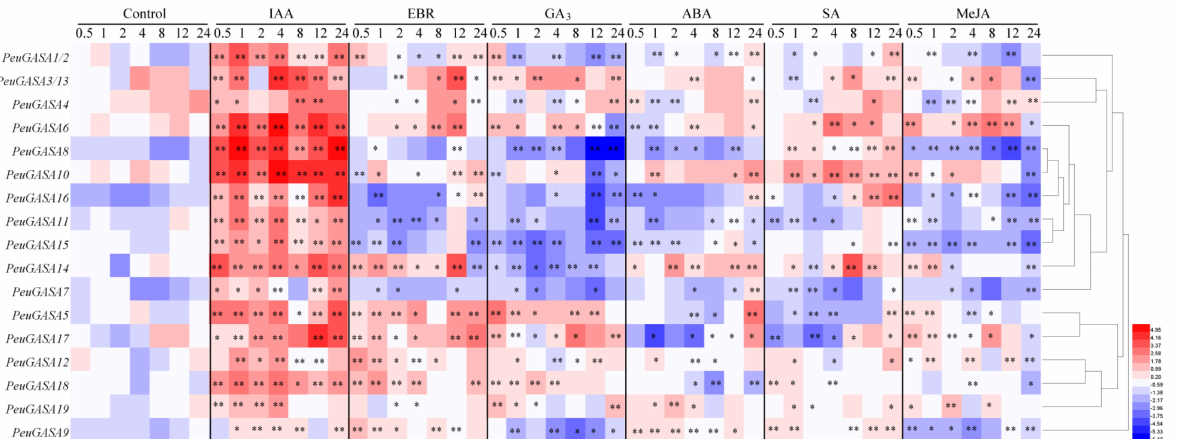
Figure 7. Expression analysis of PeuGASA genes in response to SA, ABA, MeJA, EBR, GA 3 and IAA treatments. Numbers are the time (h) of treatment. The heat map was based on the calculation of three replicates of qRT-PCR data and the transformation of log2 algorithm. Multiple comparisons were evaluated based on the least significant difference (LSD) test to calculate p -values (Asterisks denoted significant differences: * p ≤ 0.05; ** p ≤